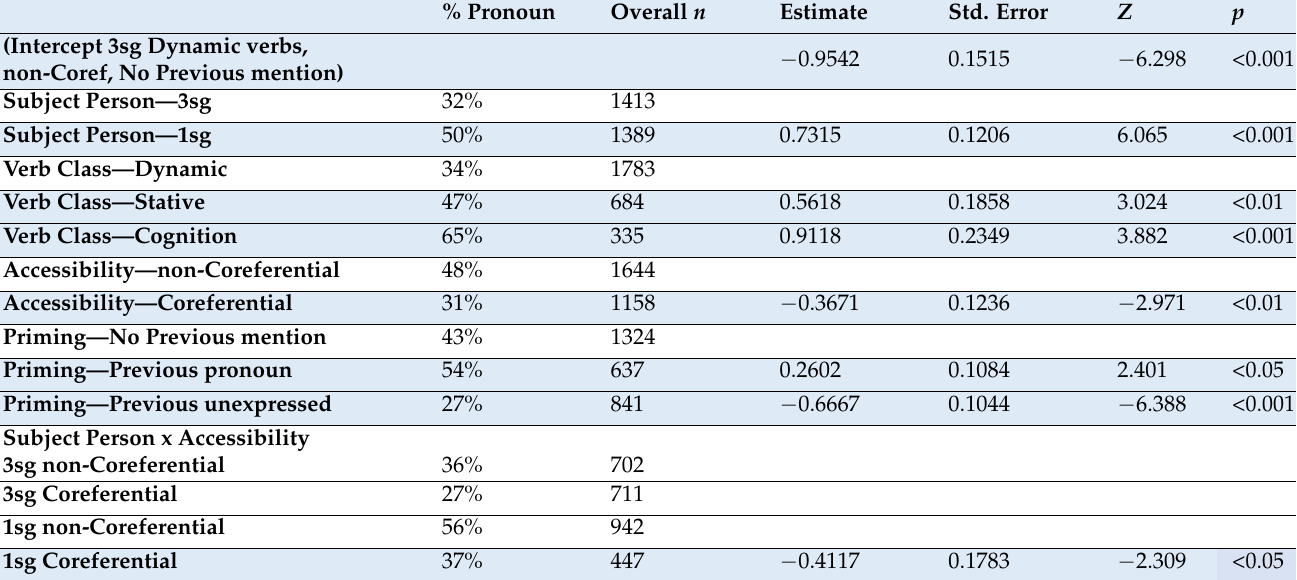
Table 1. Generalized linear (mixed) model predicting an expressed subject.